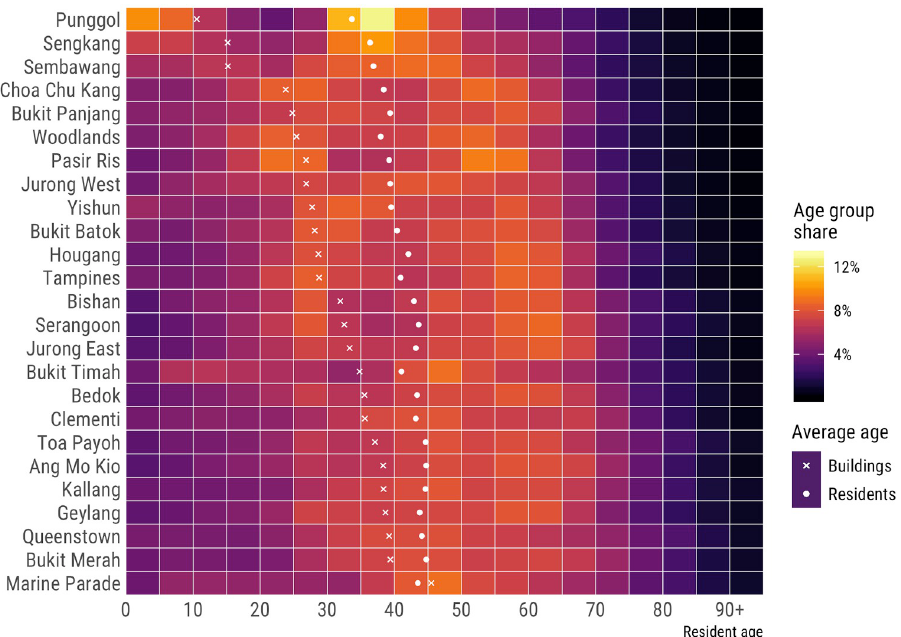
Fig 3. Visualisation of some of the datasets that we have used in our work. Proportion of age groups by administrative area (from which we calculate the proportion of seniors and the average age—plotted as well) together with the average age of buildings. The plot hints at disparate demographics of neighbourhoods and at an association between the age of buildings and age of residents, which we attempt to take advantage of in our estimations. Source of the datasets: Singapore Department of Statistics and Housing and Development Board